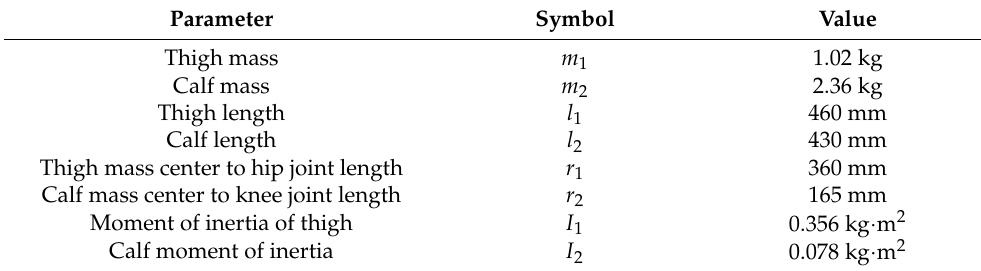
Figure 4. Structural principle of MR prosthesis. Table 3. Key parameters of MR